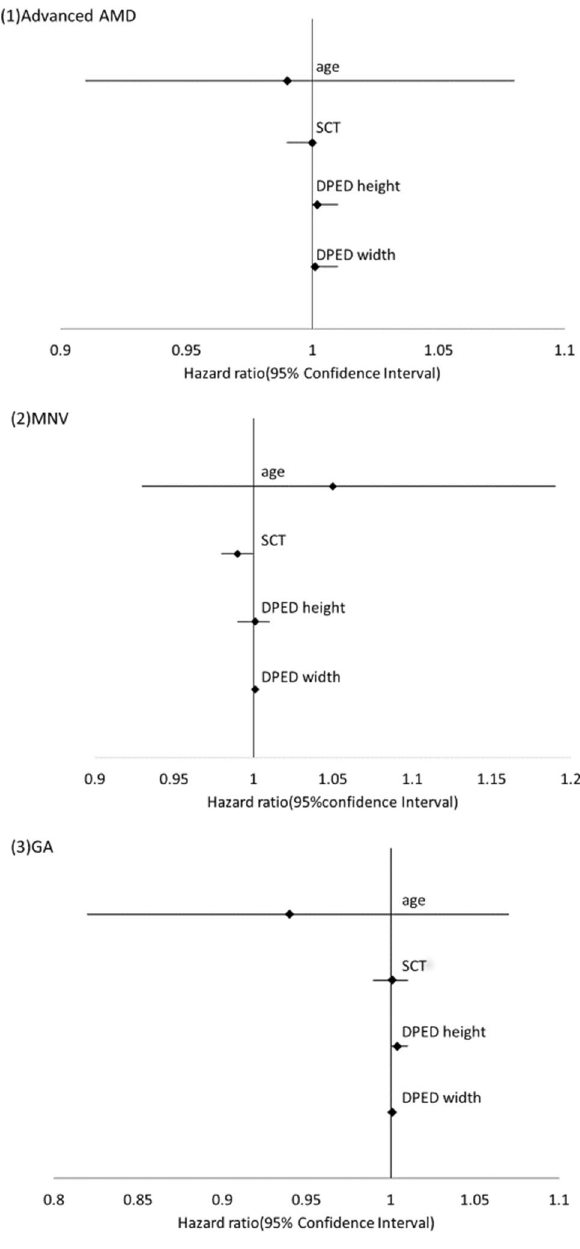
Figure 4. Forest plots showing the hazard ratio associated with advanced AMD, MNV and